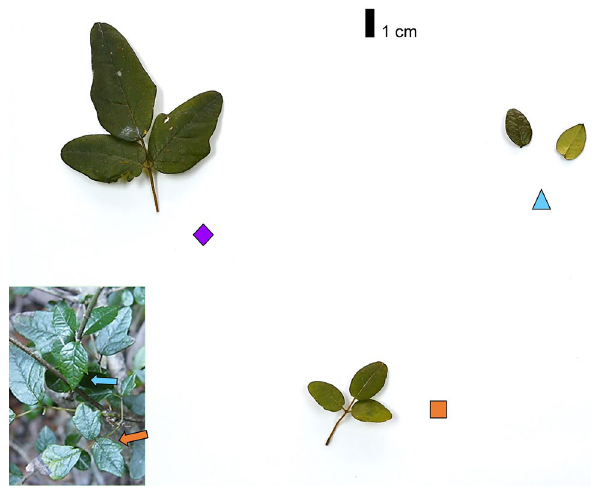
Figure 1. One of the five sets of leaf samples collected in the field in associations between the model tree Rhaphithamnus spinosus and the vine Boquila trifoliolata . RS = two leaves from R. spinosus [sky blue triangle], BR = a single Boquila leaf—composed of three leaflets—mimicking the tree leaves [orange square], and BT = a single Boquila leaf from the same individual vine but not mimicking the tree leaves [purple rhombus]. Inset: field picture showing leaf mimicry of R . spinosus [sky blue arrow] by Boquila [orange arrow] (photo credit: E. Gianoli). Note that leaf mimicry is accomplished for both ovate leaves (study samples) and cordate-lobed leaves (inset) of the tree. For other cases of Boquila mimicking R . spinosus see 8,10